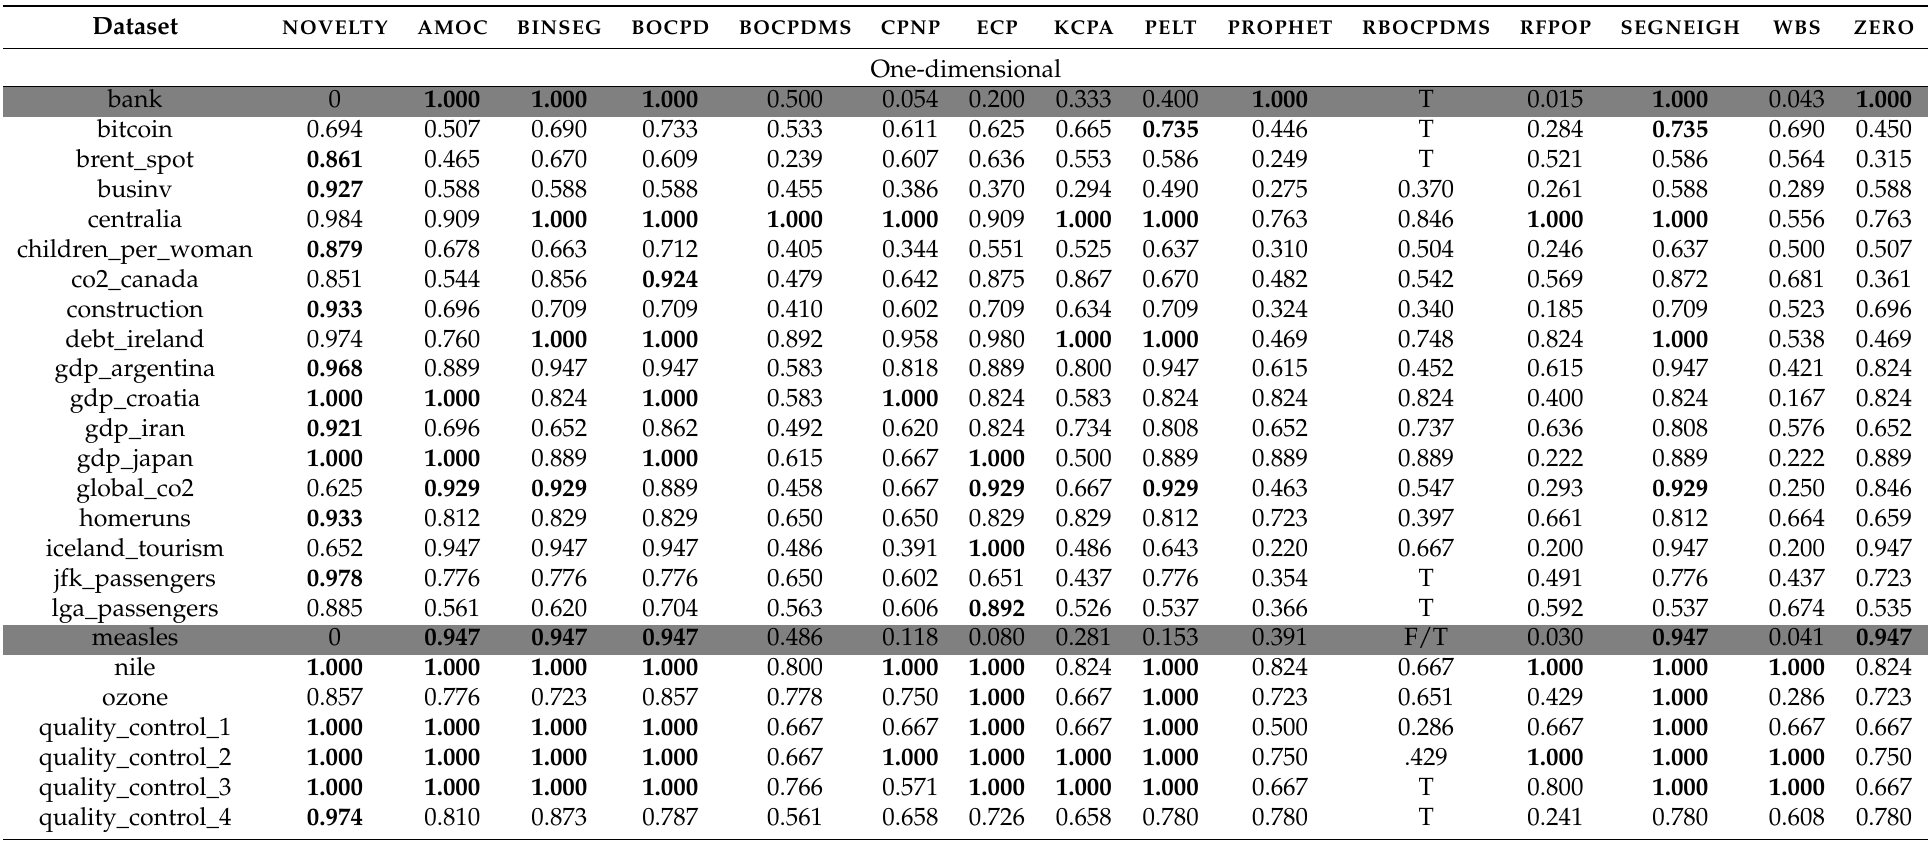
Table 3. Comparison of the F1-scores between our proposed method ( novelty ) and other algorithms’ benchmarks in Datasets 7 (ECG Pulsus Paradoxus, see Section 3.5). The calculation of all one-dimensional signals’ average performance and all signals’ average performance does not include columns with a